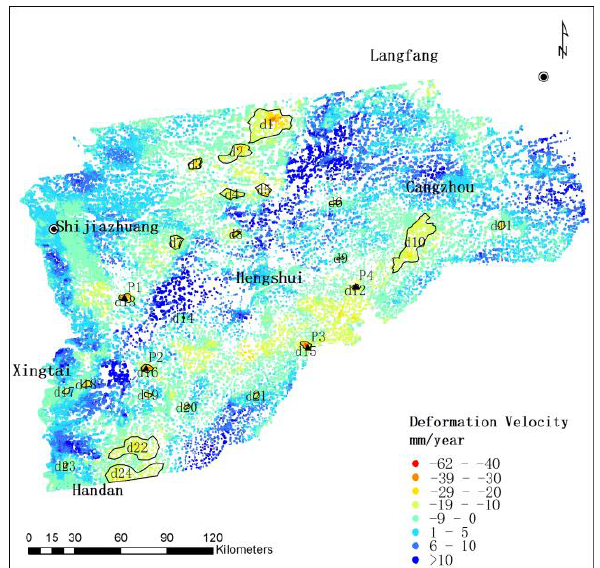
Figure 4. Deformation velocity of Hebei Plain (after merging)